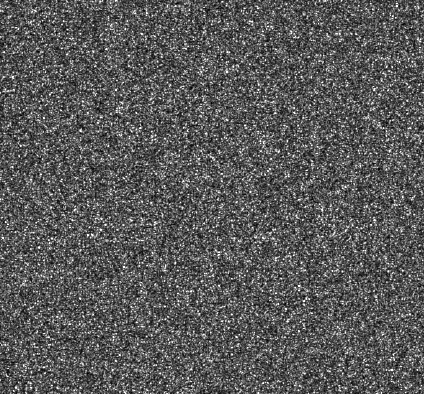
Fig. 2. A typical speckle